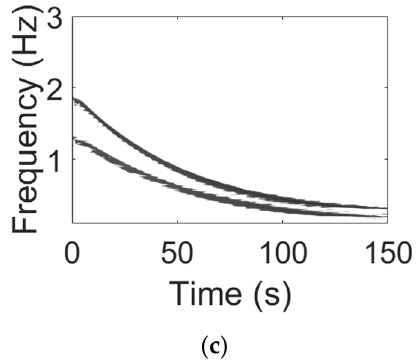
Figure 5. Synchro-squeezed wavelet transform: ( a ) lognormal wavelet; ( b ) Morlet wavelet; ( c ) bump wavelet.